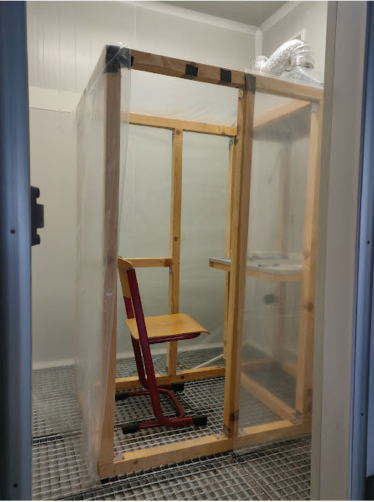
Figure 5. The exposure chamber.